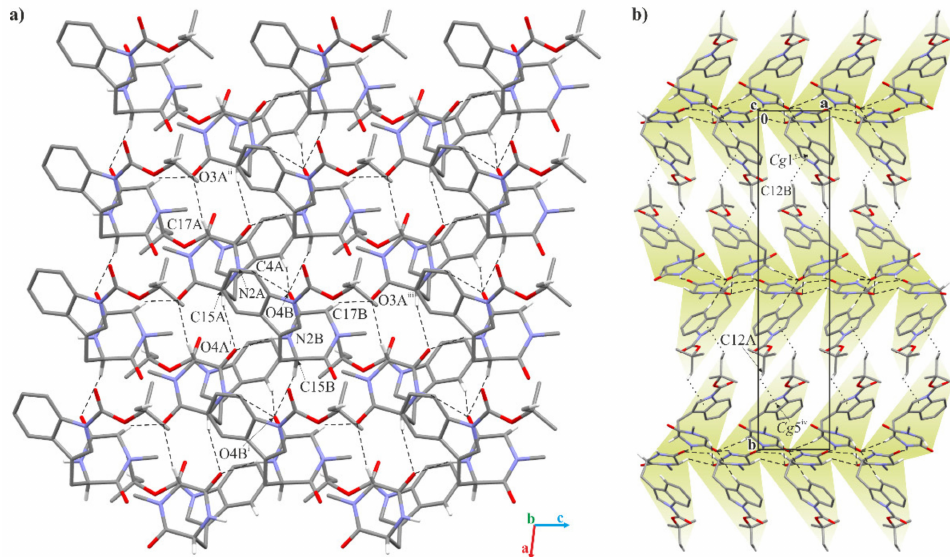
Figure 3. Arrangement of molecules of 11a in the crystal, where: ( a ) layer of molecules spreading along (001) plane; ( b ) general view on layered supramolecular architecture of compound viewed along c -direction (single layers are highlighted in light-green). The H-atoms not involved in inter- molecular interactions have been omitted for clarity. The N–H · · · O and C–H · · · O hydrogen bonds are represented by dashed lines, while the C–H · · · π contacts by dotted lines. Symmetry codes: (i)